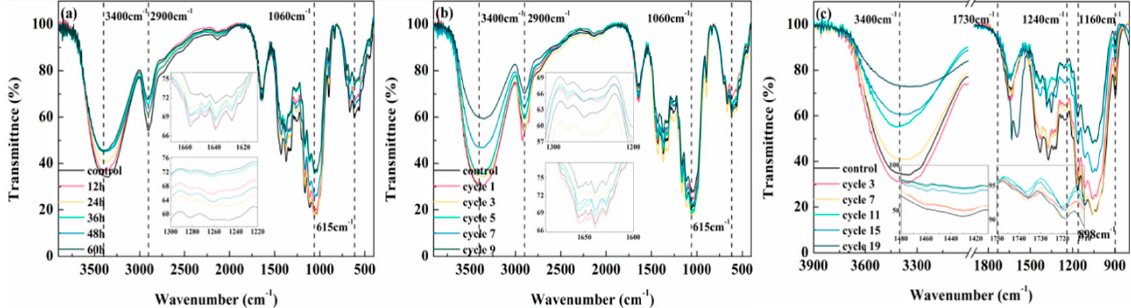
Figure 3. FTIR: ( a ) damp − heat treatment; ( b ) freeze − thaw cycle; and ( c ) artificial weathering cycle.